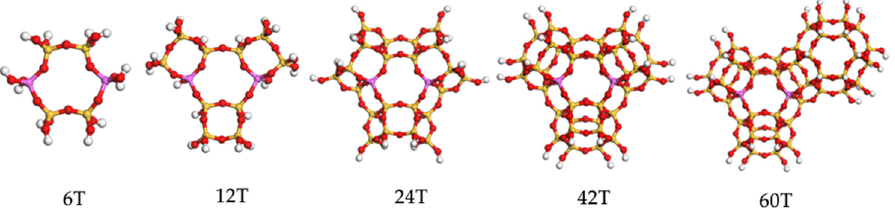
Figure 2. The cluster geometries of Y zeolite with different sizes. Red, yellow, pink and white balls stand for O, Si, Al and H atoms, respectively.